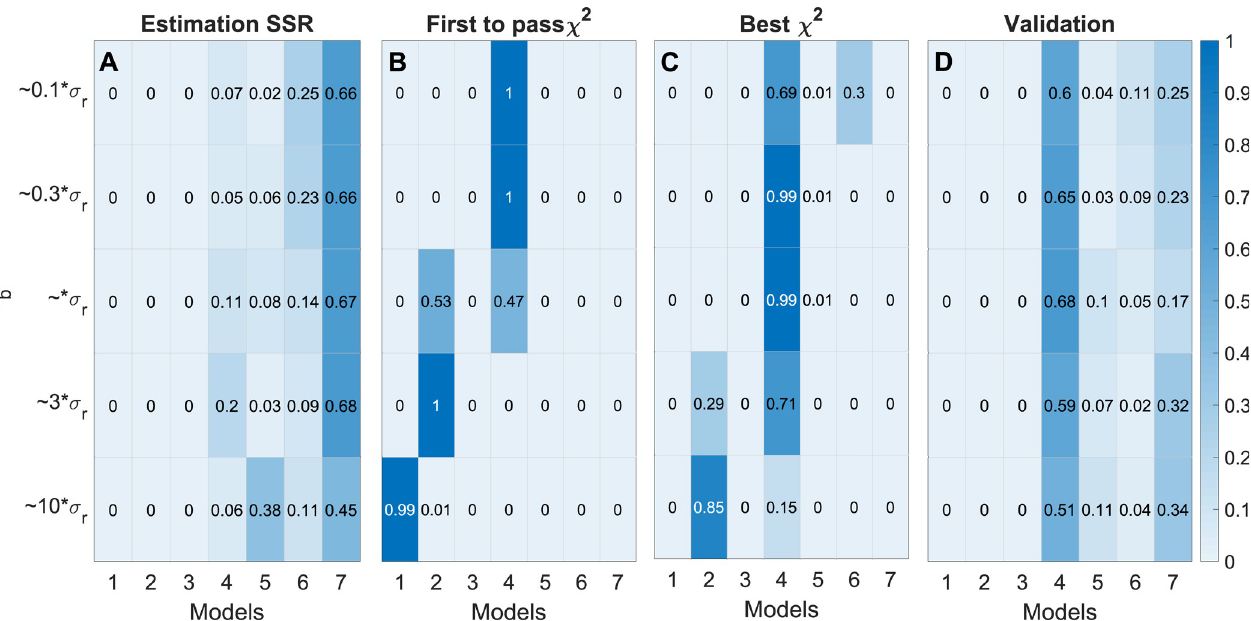
; ... ; M . For each row, color indicates the fraction of times a model is 1 7